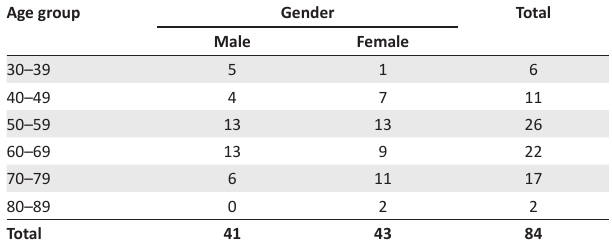
TABLE 1: Age and gender